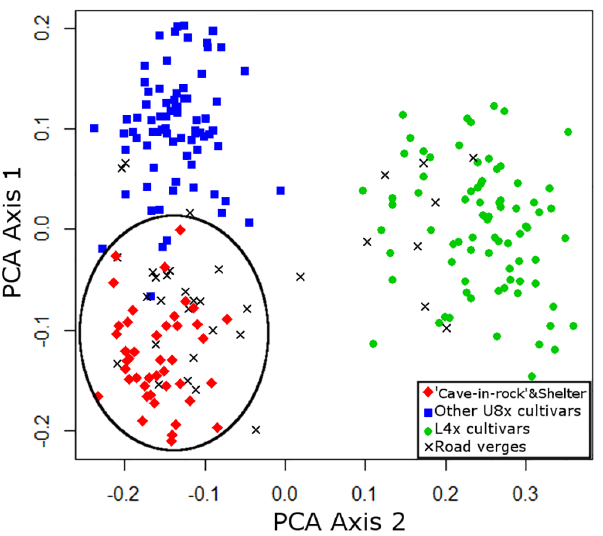
Fig 6. Principle Coordinate Analysis (PCA) of SSR markers from switchgrass collected from inland road verges and 16 cultivars representing U8x and L4x genotypes (n = 231). The circle indicates the grouping of road verge samples with cultivars ‘ Cave-in-Rock ’ and ‘ Shelter ’ . Colors indicate: ‘ Cave-in-rock ’ and ‘ Shelter ’ (Red ♦ ), Other U8X cultivars (Blue & ), L4X cultivars (Green ● ), plants from inland road verges (BlackX).